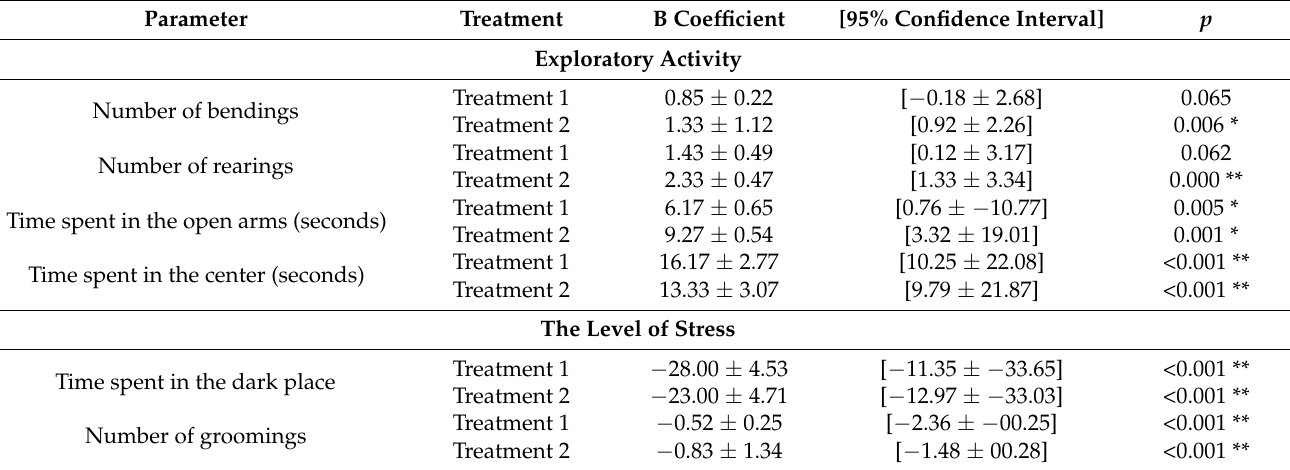
Table 5. Regression analysis of each treatment group compared with the control